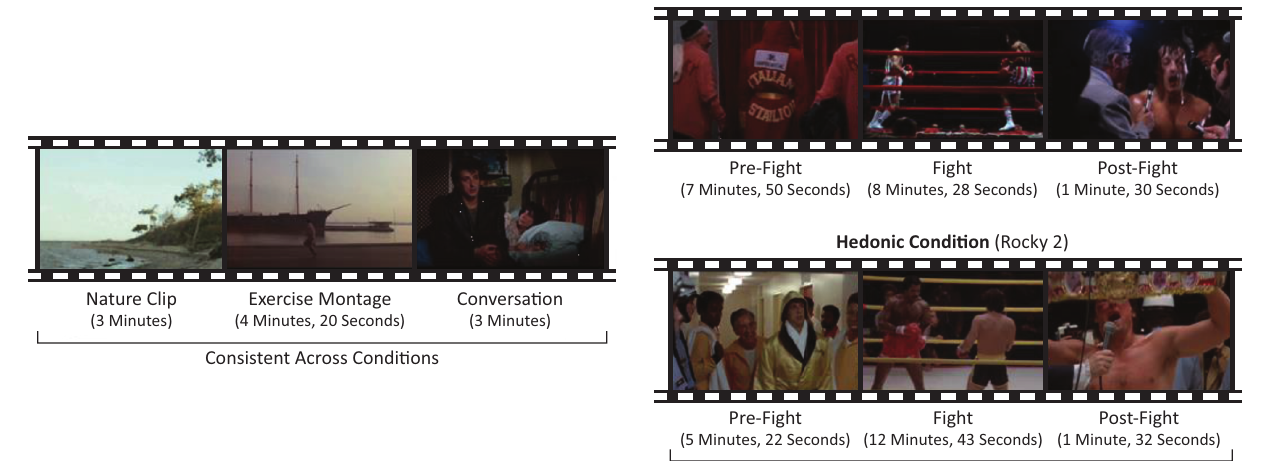
Figure 1. Timeline of stimuli between